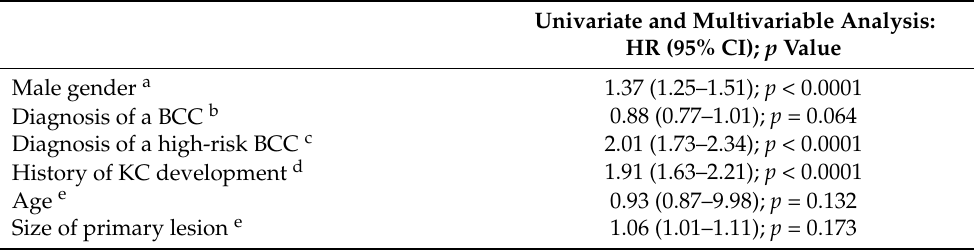
Table 2. Results of the univariable and multivariable Cox proportional hazard regression analyses of all subsequent KC survival. HR, hazard ratio; 95% CI, 95% confidence